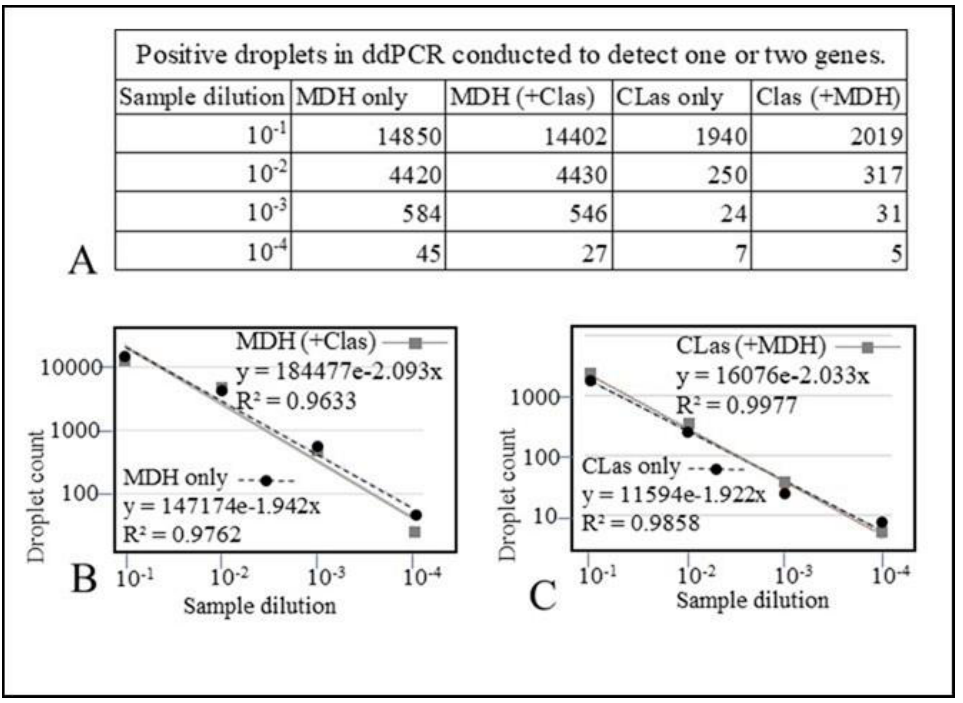
Figure 5. ddPCR of CLas and MDH in singleplex and duplex assays. Serial dilutions of a CLas positive citrus DNA extract were made using TE as a diluent. Columns 2 and 3 in panel ( A ) show number of positive droplets for MDH assay when conducted alone or with CLas. Columns 4 and 5 show the number of droplets recorded as positive for CLas in singleplex or duplex assays (conducted with MDH). Panel ( B ) shows the regression line for MDH (conducted with or without CLas). Panel ( C ) shows regression analysis for CLas conducted with or without MDH.